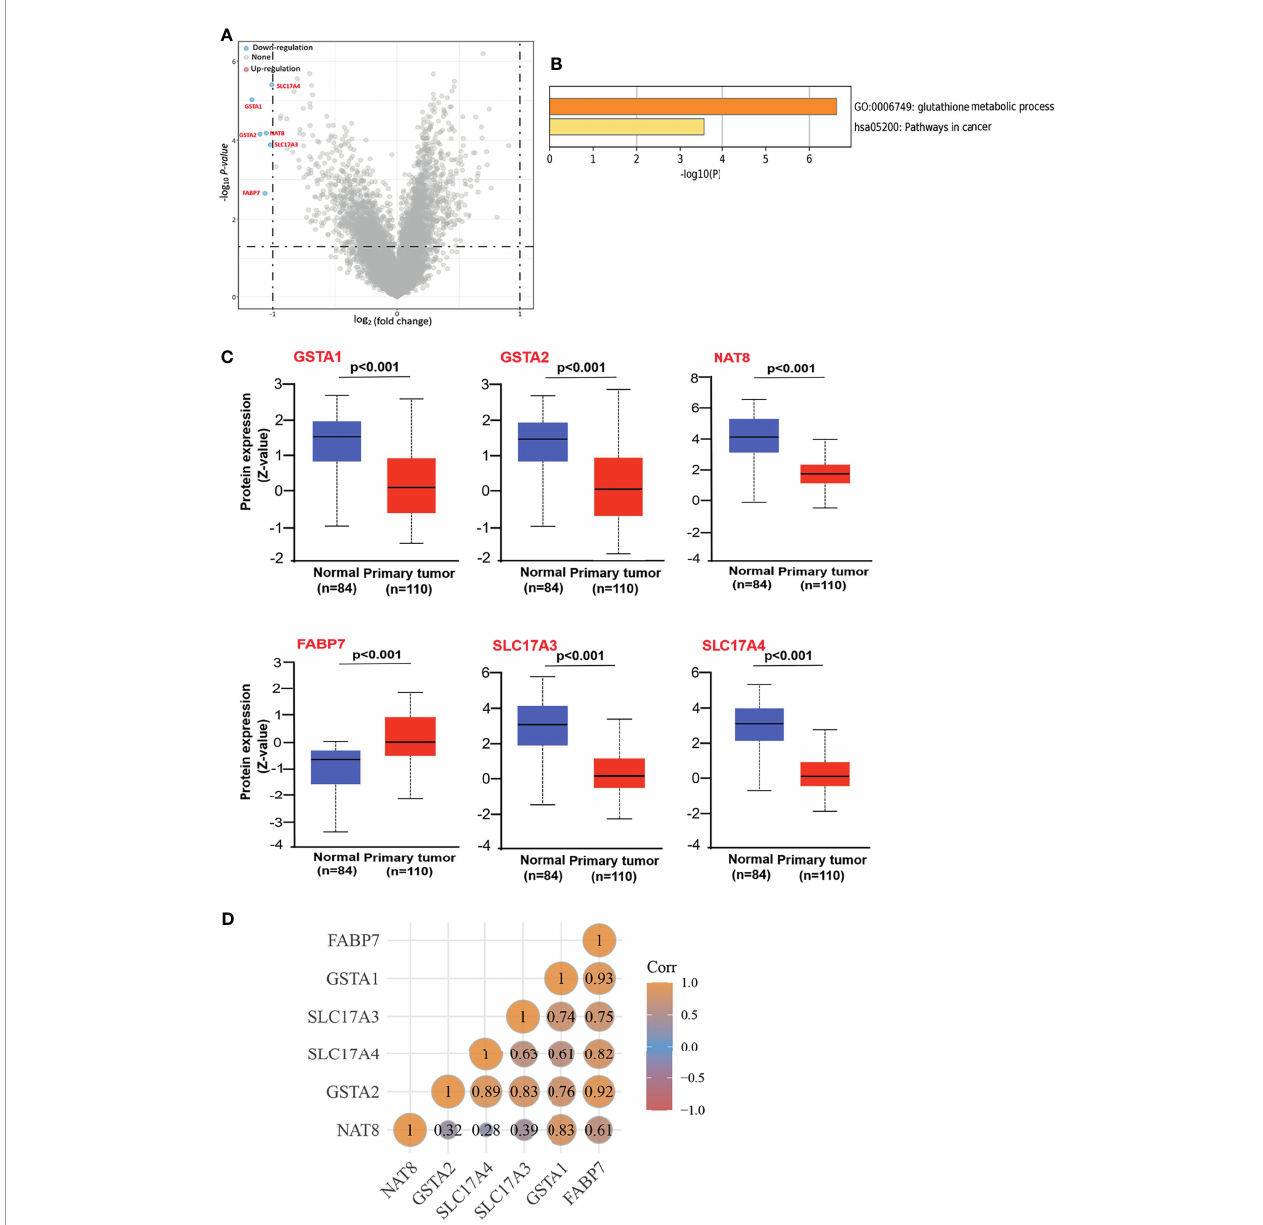
FIGURE 1 | Screening out the DEGs and identifying their characteristics, (A) Volcano plots to screen out the DEGs between patients with wild-type and mutation VHL. The blue point indicates the down-expressed mRNAs with statistical signi fi cance. The default set of the threshold was fold change ≥ 2, P ≤ 0.05. (B) GO Enrichment analyses of DEGs. GO, gene ontology. (C) Based on the CPTAC dataset, we analyzed the total protein expression level of GSTA1, GSTA2, NAT8, FABP7, SLC17A4, and SLC17A4 in normal tissue and primary tissue of ccRCC. (D) Spearman correlation analysis between DEGs. The value represents the correlation p-value, and the darker the color represents a stronger